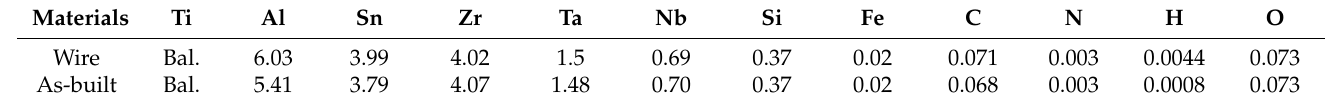
Figure 3. Chemical compositions of the wire feedstock and the as-built alloy along the build direction, Al, Sn, Zr ( a ) and Ta, Nb, Si ( b ). Table 2. Chemical composition of the wire and EB-DED Ti60 alloy (wt.%).